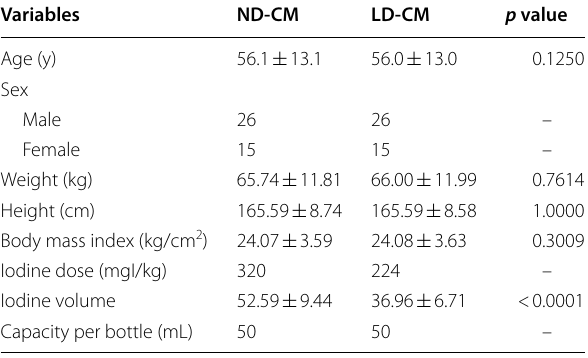
41) and contrast dose =